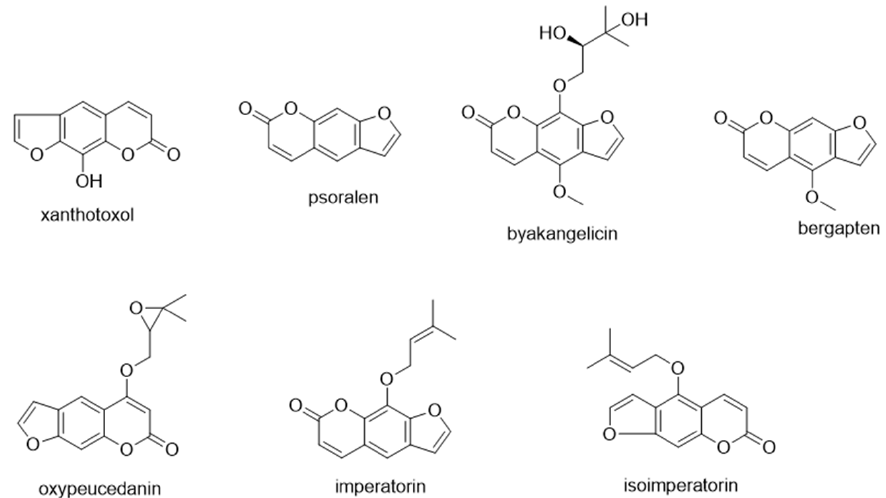
Figure 1. Chemical structures of xanthotoxol, psoralen, byakangelicin, bergapten, oxypeucedanin, imperatorin, and isoimperatorin.